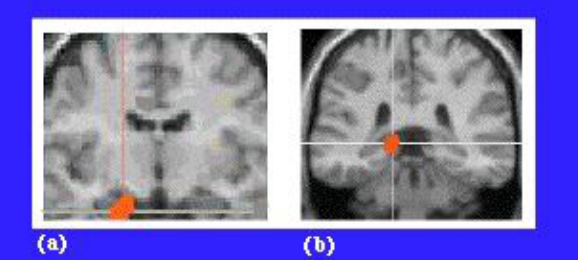
Fig. 1. SPM z-maps of left MTL activations produced by encoding processes carried out during (a) the associative encoding task ( − 16 − 10 − 16, BA 28/35) and (b) the thematic encoding task ( − 14 − 36 0, BA 27/30) when compared to the same baseline perceptual